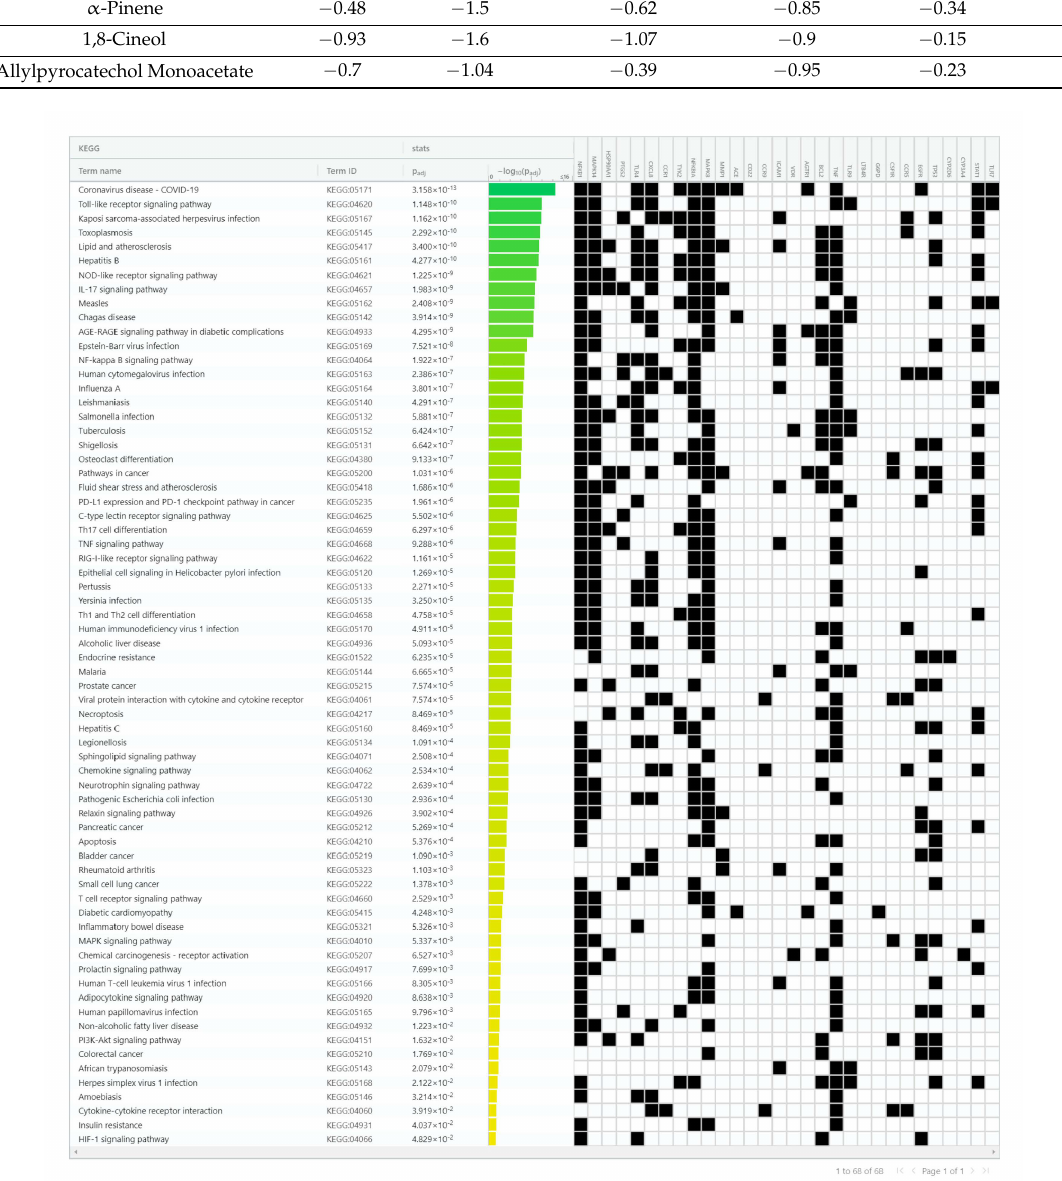
Figure 7. Biological pathway enrichment analysis of identified bioactives against COVID-19. KEGG enrichment pathway analysis identification result according to an adjusted p -value of 0.05 and the ordinate indicates the − log10 (adjusted p -value) of the KEGG